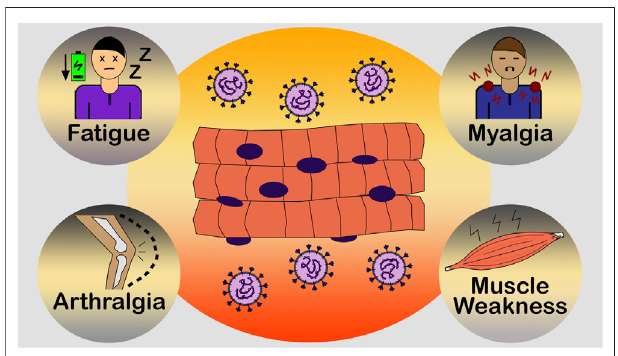
FIGURE 3 | Common muscle symptoms of COVID-19. Fatigue, arthralgia (joint pain), myalgia (muscle pain) and muscle weakness have been reported as initial and common symptoms by SARS-CoV-2-positive individuals. These extenuating symptoms can affect the daily lives of numerous individuals, reducing their quality of